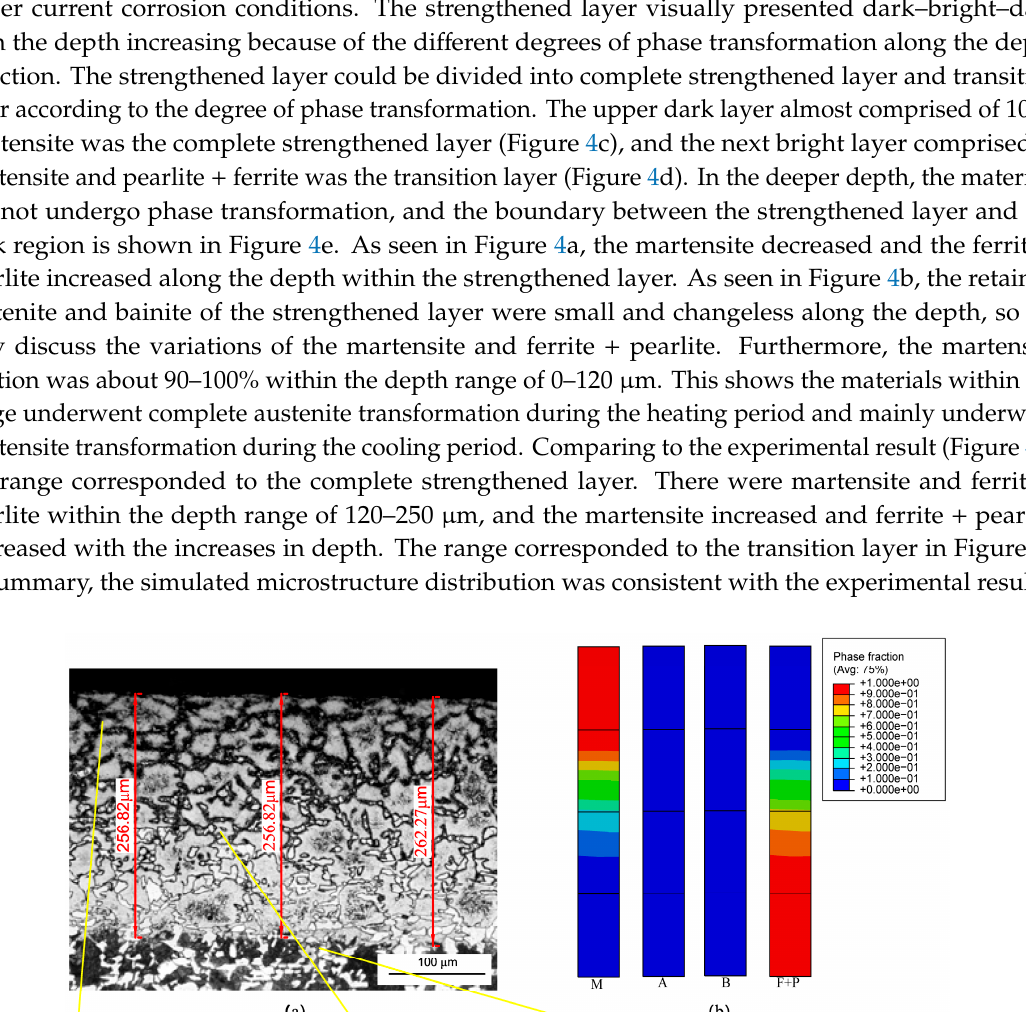
Figure 5. Microstructure distribution of the strengthened layer under no. 2 grinding parameter: ( a ) experimental result; ( b ) simulated result.